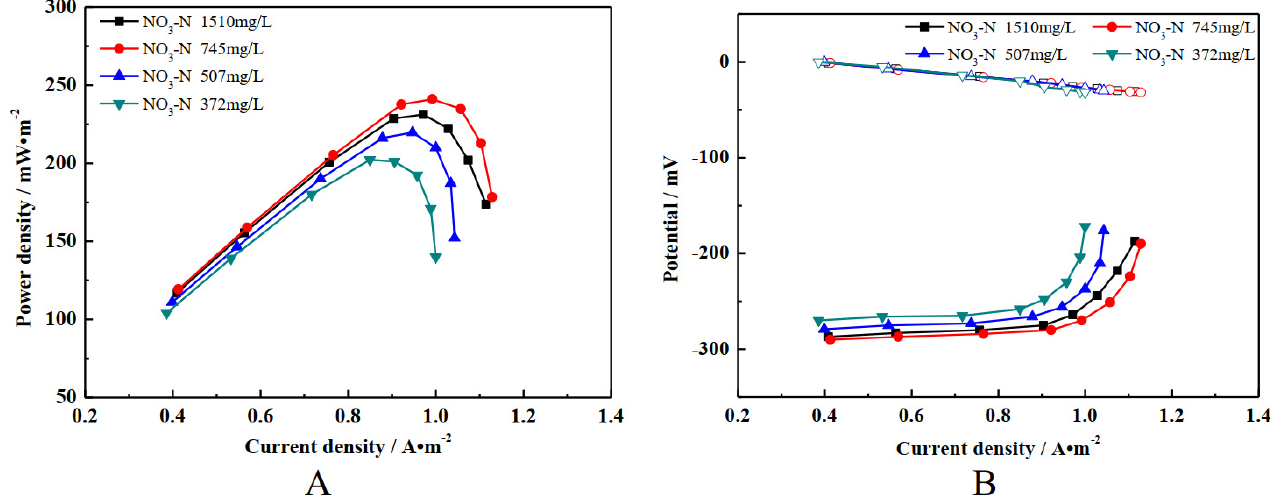
Figure 5. Power density curve ( A ) and polarization curve (( B ): close circuit symbol, cathode potential; open circuit symbol, anode potential) under different initial nitrate nitrogen concentrations.